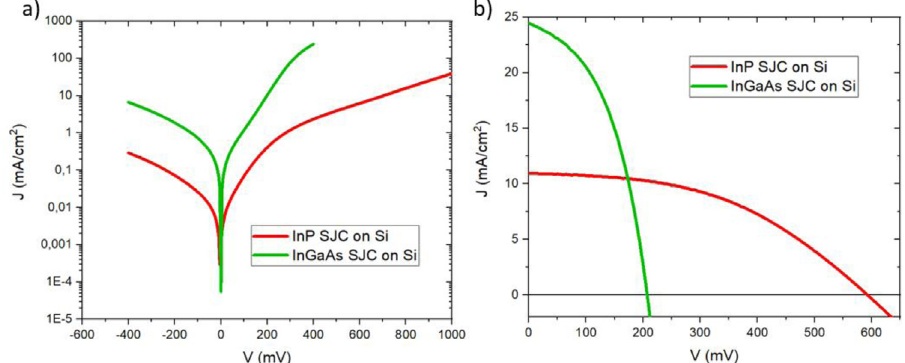
Fig. 9. (a) J – V characteristics under dark conditions of the two solar cells integrated on Si. (b) J – V characteristics under 1-sun illumination of the two single solar cells integrated on Si. The InP cell is represented in red, whereas the InGaAs cell in green. Table 4. Parameters of the two solar cells integrated on Si. InP InGaAs